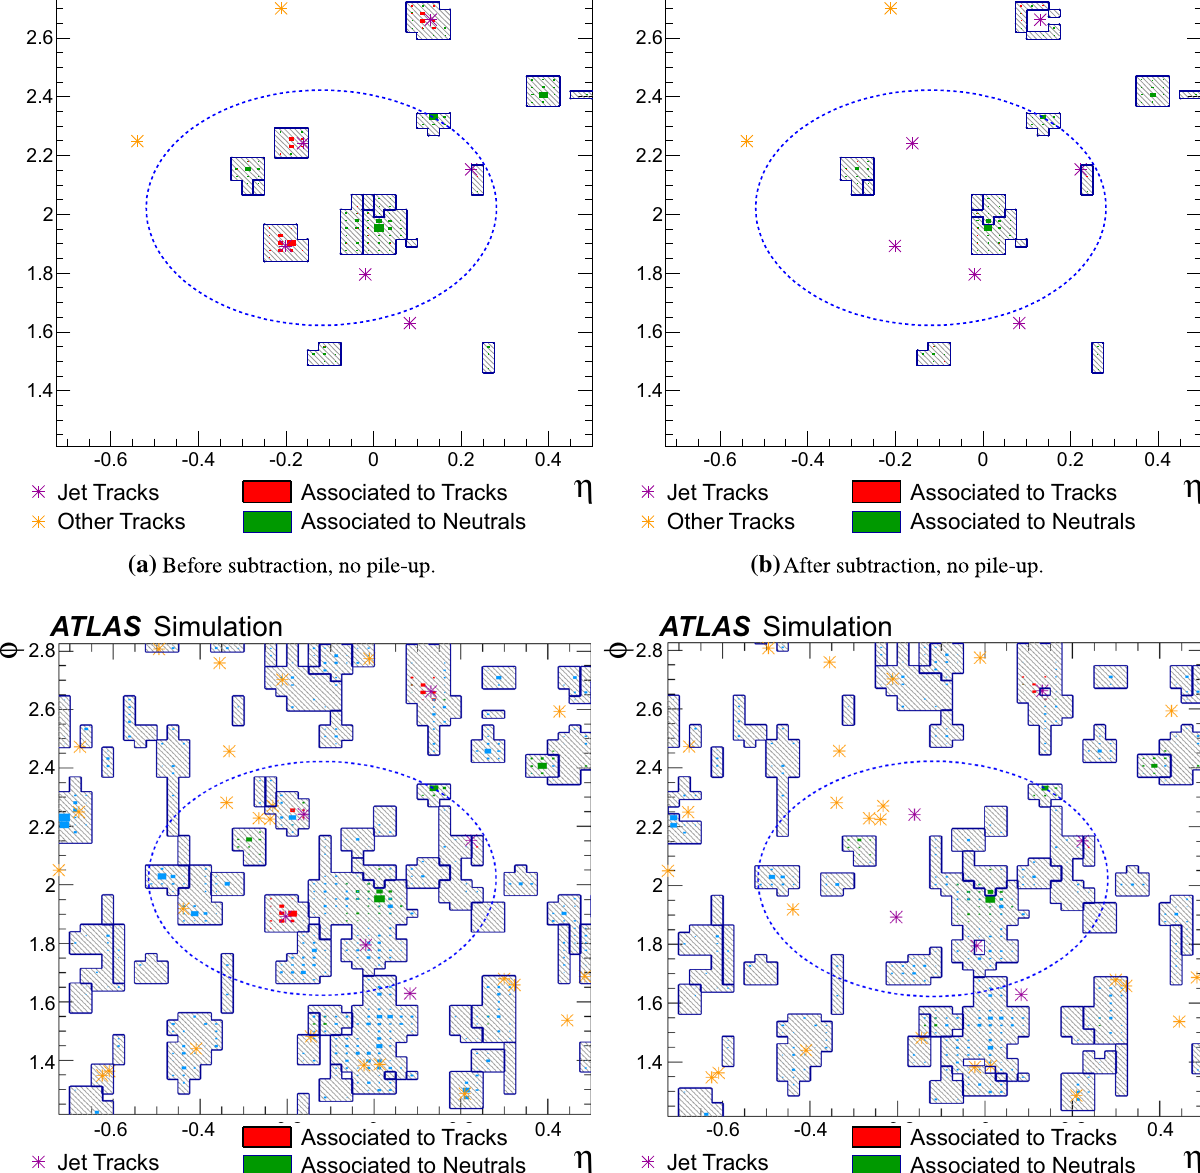
on their momenta expressed at the perigee. Other tracks are shown in orange ( light ). Red and green boxes indicate reconstructed cell ener- gies associated with truth particles where tracks have and have not been reconstructed. Subfigures ( a ) and ( b ) show the event without pile-up. Subfigures ( c ) and ( d ) show the same event with pile-up overlaid. Pile- up energy in the calorimeter is indicated by blue